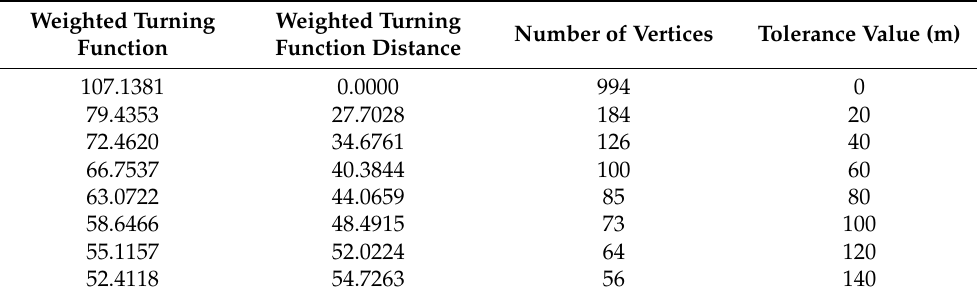
Table 6. Computation of turning function distances (as length difference) per tolerance value (line